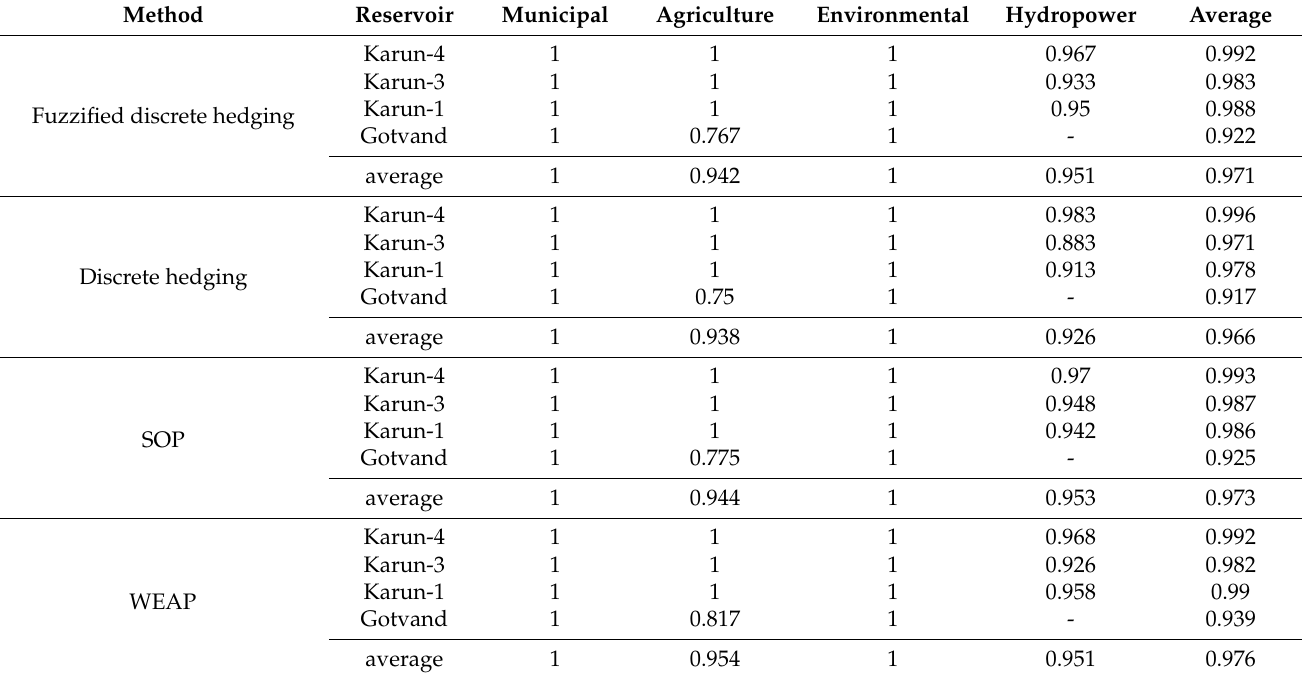
Table 4. Average monthly reliability for the test